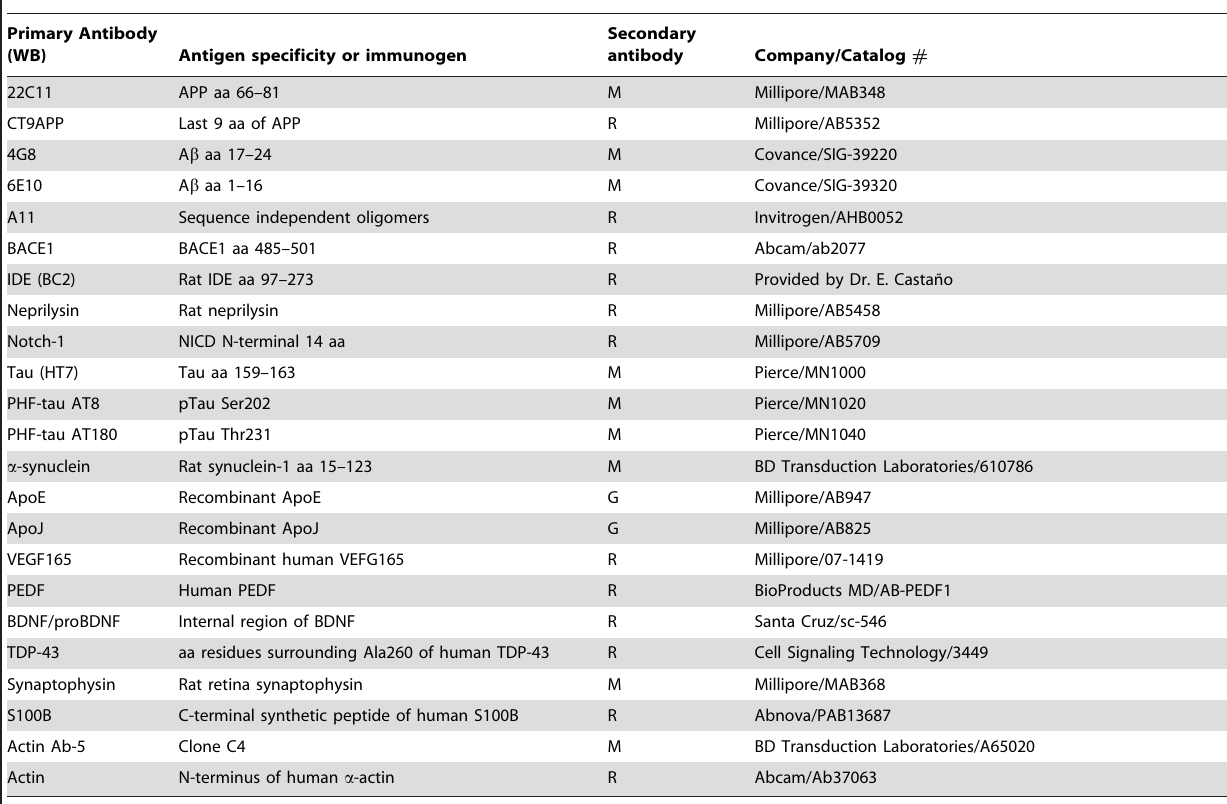
Table 2. Primary and Secondary Antibodies Used in Western Blots.